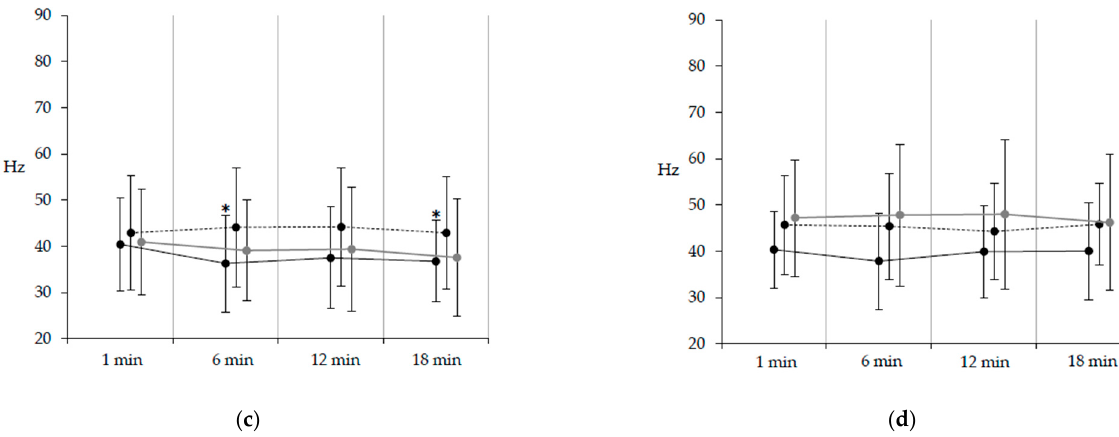
Figure 2. Temporal changes in the instantaneous mean frequency (IMNF) during the extended walking test. Values are expressed as mean (standard deviation). ( a ) Tibialis anterior; ( b ) Soleus; ( c ) Rectus femoris; ( d ) Biceps femoris. The solid line represents the paretic side, the dotted line represents the nonparetic side, and the gray line represents healthy subjects. The IMNF of the tibialis anterior on the nonparetic side significantly decreased at 18 min compared with that at 1 min. The IMNF of the rectus femoris on the paretic side significantly decreased at 6 min and 18 min compared with that at 1 min.